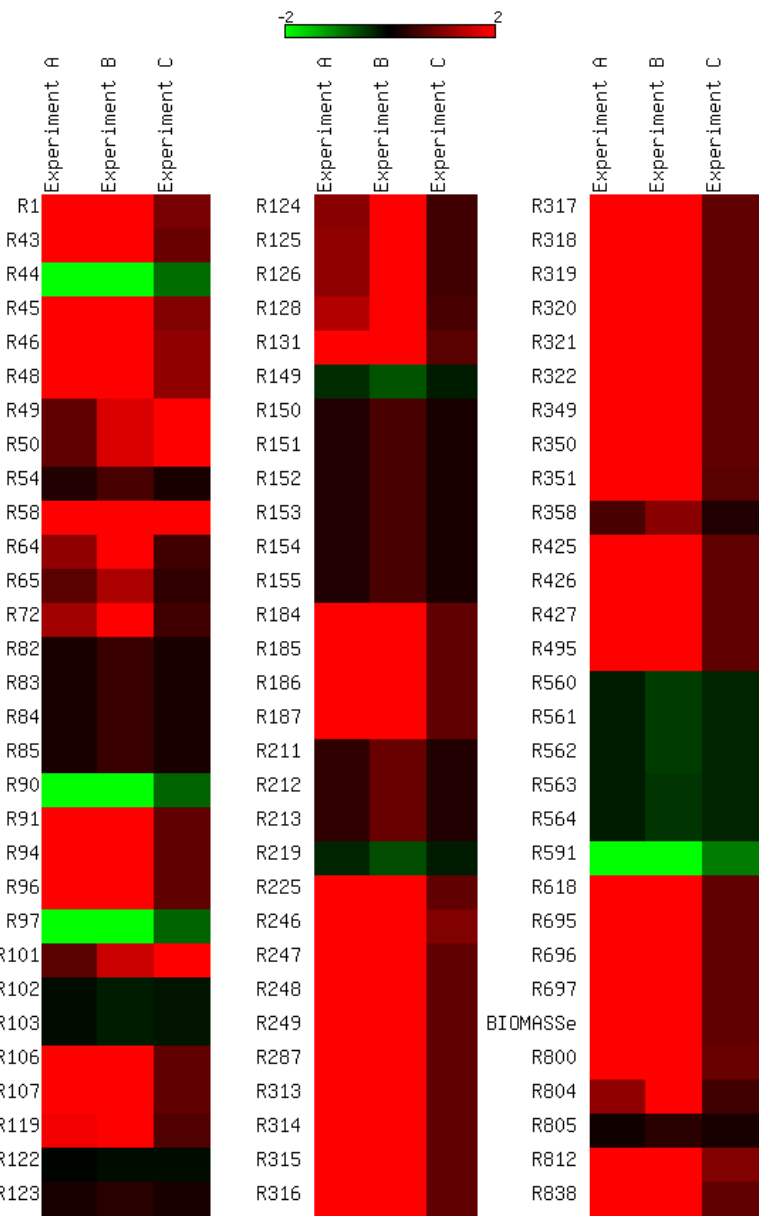
Figure 3. Relative changes in flux with changes in glycerol consumption rate. The response of selected reactions when the glycerol uptake rate is at 0 and 0.5 mmol/gDW/h is compared in Experiment A, between 0 and 1 mmol/gDW/h in Experiment B, and between 0.5 and 1 mmol/gDW/h in Experiment C. Only reactions with an absolute change greater than 10 % (0.1) and an absolute flux greater than 0.01 are shown. Green indicates a decrease and red indicates an increase in flux. Reactions identifiers are the same as in the Beste